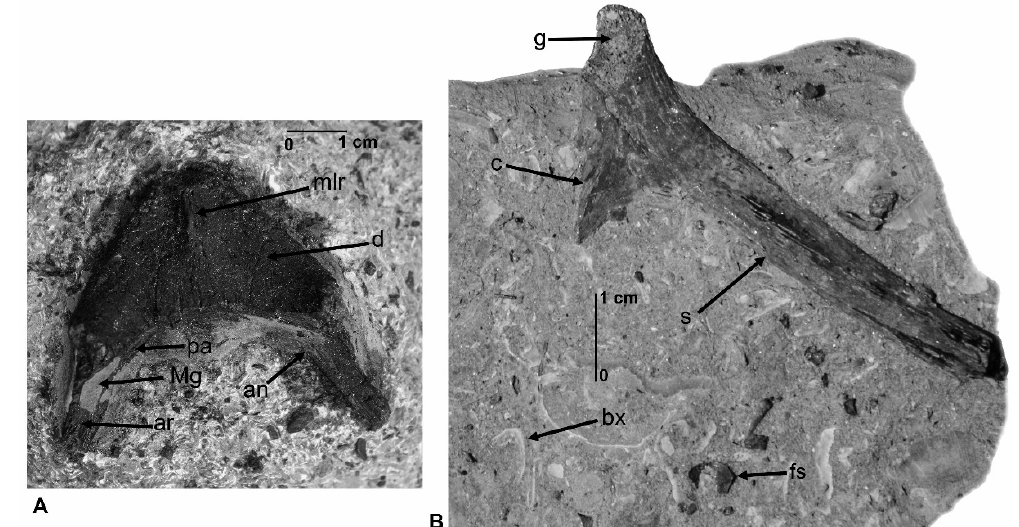
Figure 8. Turtle mandible and shoulder girdle from the basalmost Midway Group lag deposit Hot Spring County, Arkansas. ( A ) Mandible (NJSM GP23409) in interior view; ( B ) shoulder girdle (NJSM GP23400) in interior view. Scale bars in A and B = 1 cm. Abbreviations: an: angular, ar: articular,